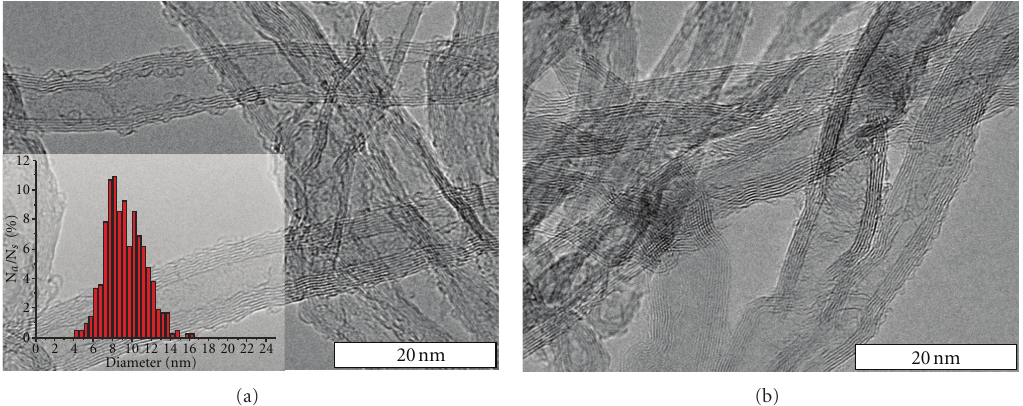
Figure 1: (a) High resolution TEM image of initial MWNTs with corresponding diameter distribution; (b) high resolution TEM image of the brominated sample, revealing no significant structure changes in nanotubes.